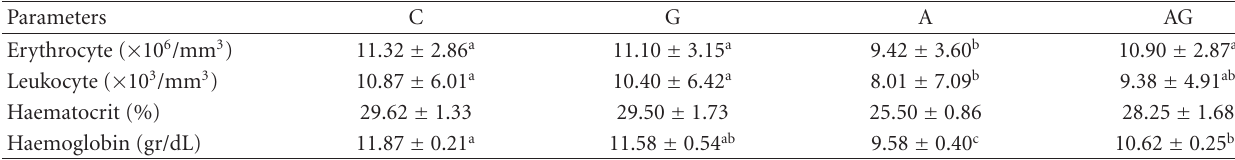
Table 2: E ff ects of AF and glucomannan on some haematological parameters ( n = 8, X ± SX). Parameters